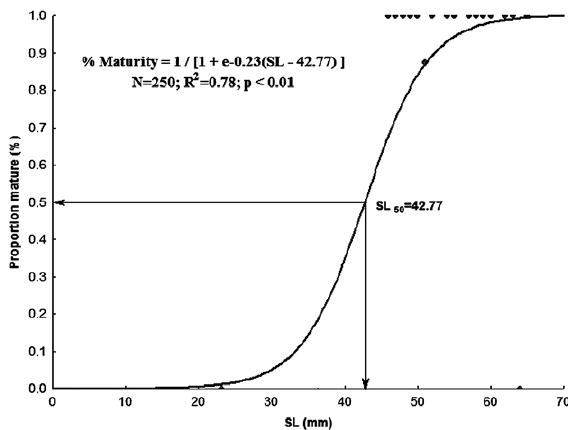
Fig. 8. – Shell length at first maturity for A. tuberculata . Proportion of mature individuals in May 2012 in relation to shell